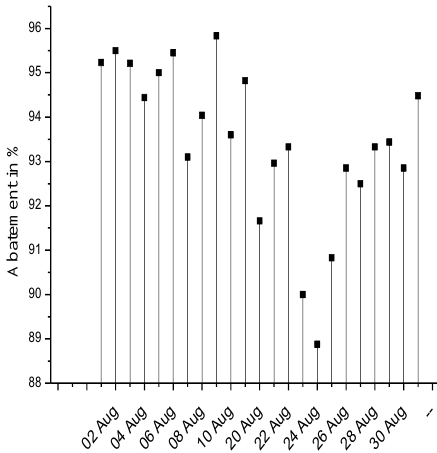
Figure 4. Daily variation of the abatement of suspended solids in %